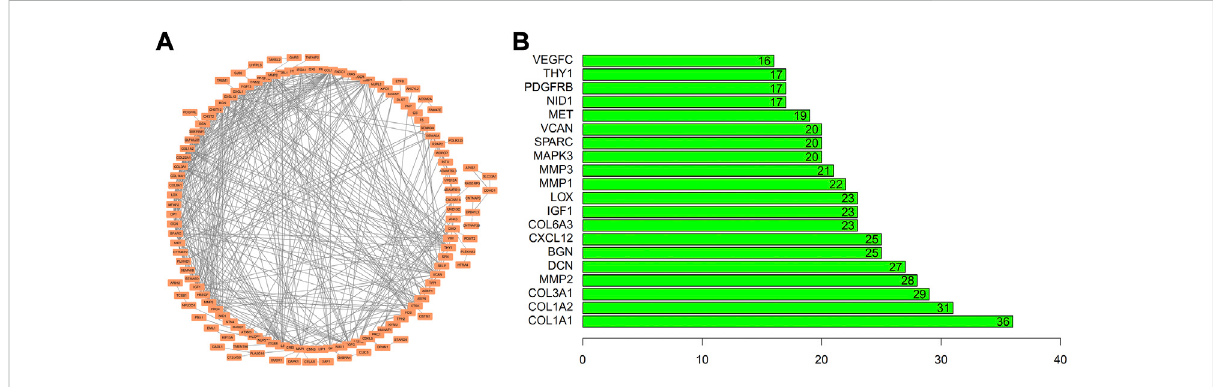
FIGURE 8 Development of PPI network/pivotal gene evaluations. Biomarkers for TSNE cell-type-1 were applied upon (A) PPI network and assessed (B) through quantifying nodes. Abscissa is displayed as the node